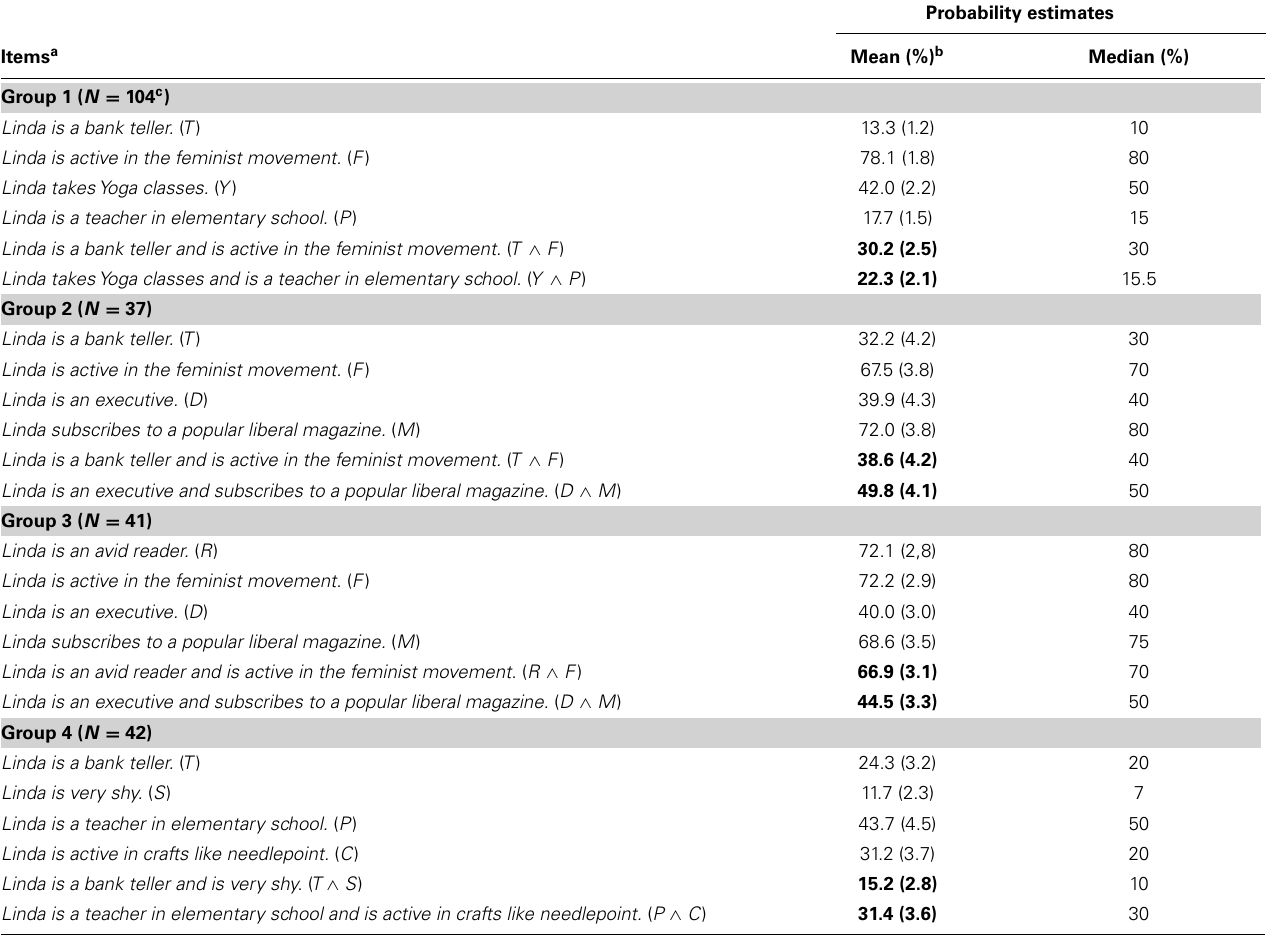
Table 1 | Means and median probability estimates in the